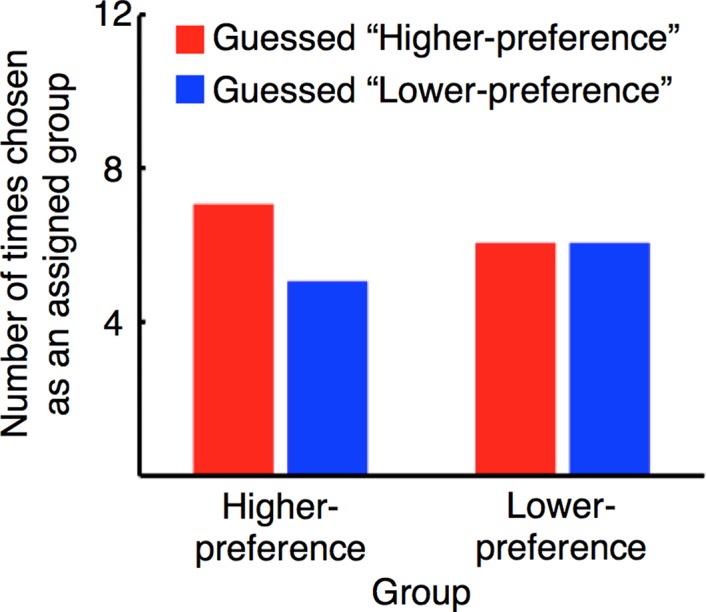
Results of the interview stage.The two left bars and two right bars show subjects’ guesses as to which group they had been assigned for the higher- (n = 12) and lower- (n = 12) preference groups, respectively.